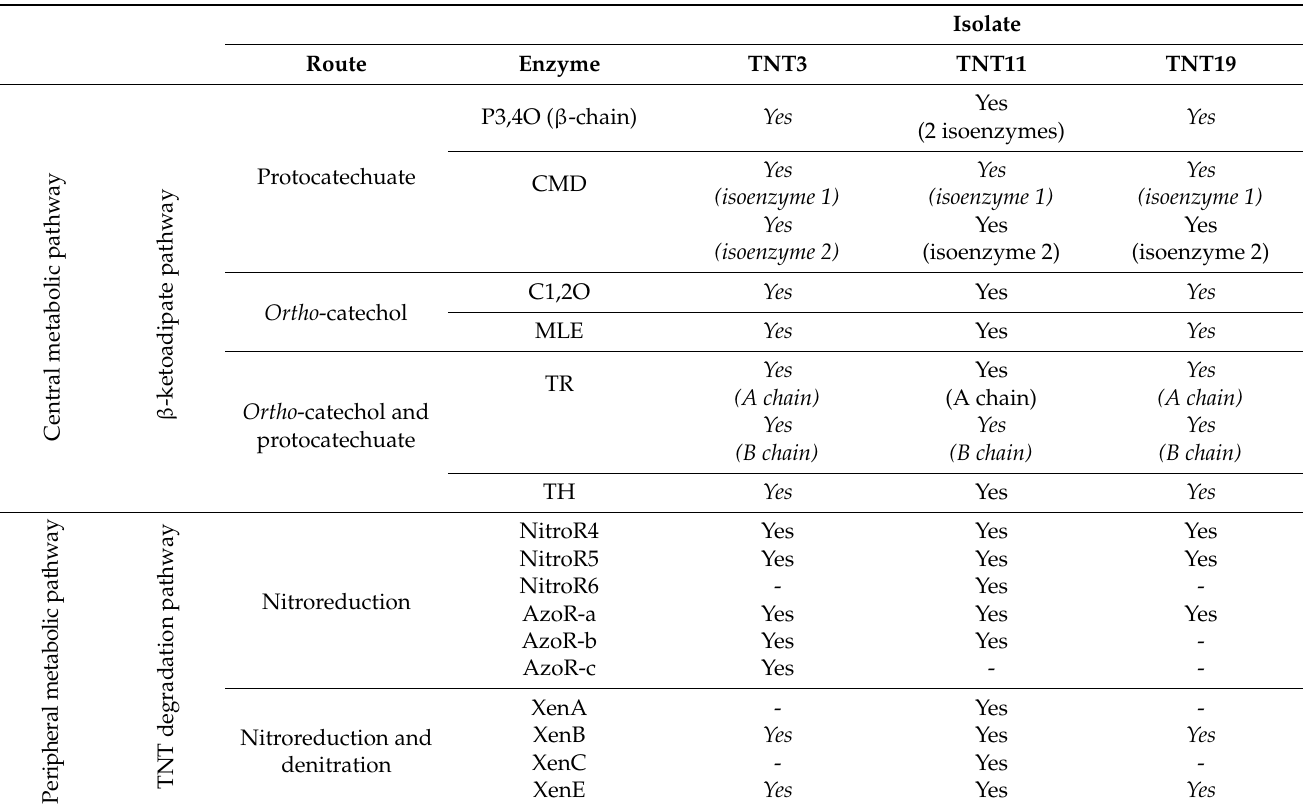
Table 2. Putative enzymes potentially involved in 2,4,6-trinitrotoluene (TNT) transformation that are present in TNT isolates.